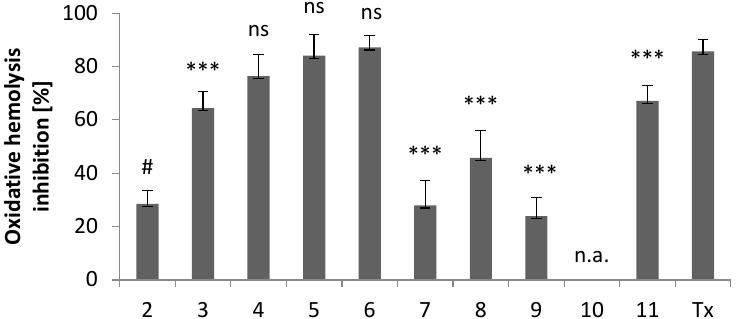
Figure 6. Cytoprotective activity of compounds 2 – 11 and the standard antioxidant Trolox against oxidative hemolysis induced by free radicals generated from AAPH. The results ( n = 7) are presented as the mean value ± standard deviation (*** p < 0.001) in comparison with the standard antioxidant Trolox. Non statistically significant difference ( p > 0.05) is indicated as ns. Inactive compounds are indicated as n.a. # Data published in [18].